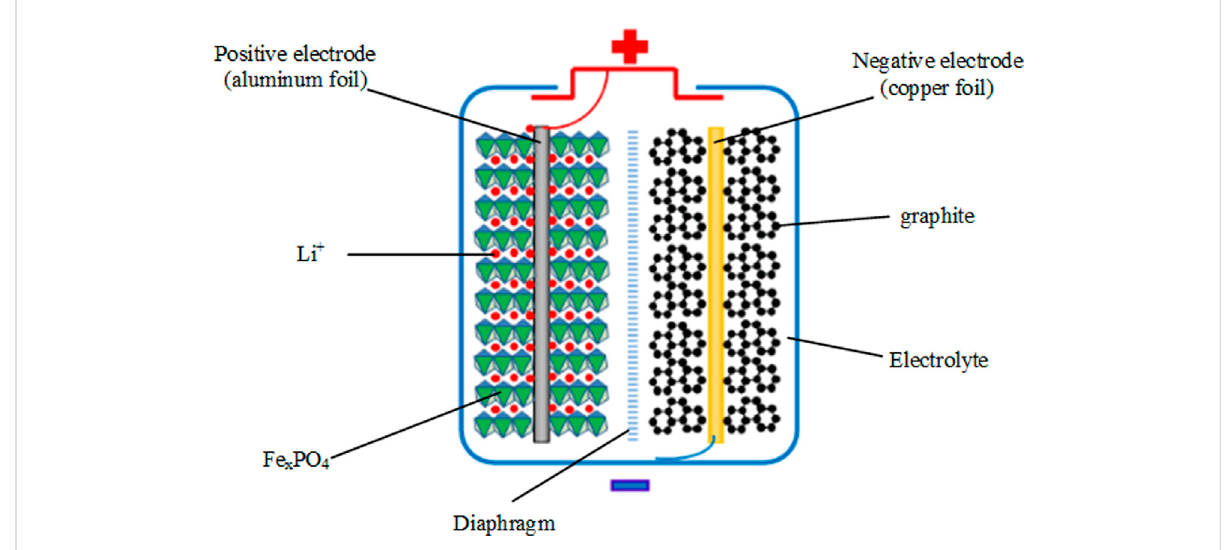
FIGURE 1 Internal structure of lithium iron phosphate